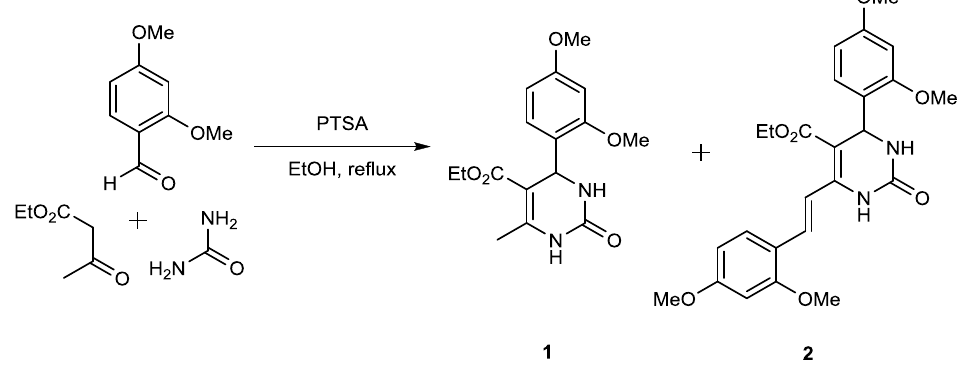
Figure 1. Biginelli reaction producing compound 2 .